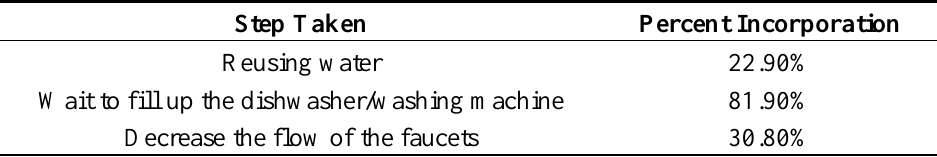
Table 11. Percentage of residential buildings which have adopted steps to reduce DHW consumption (2008) [35].